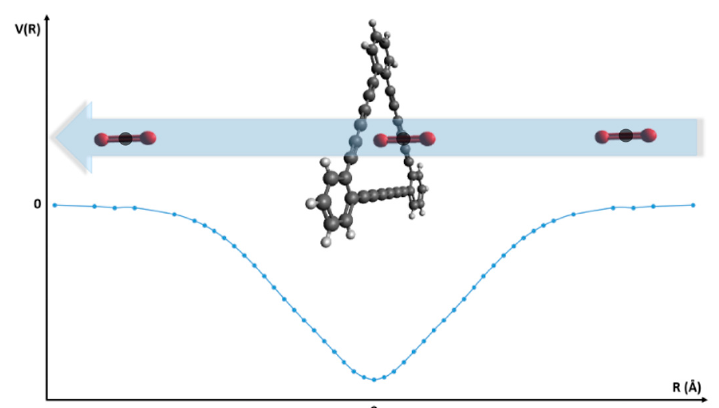
Figure 4. An illustration of the permeation process of CO 2 , displayed through a pore unit of the graphtriyne layer (adopted from the potential energy curve reported in Ref. [50]).